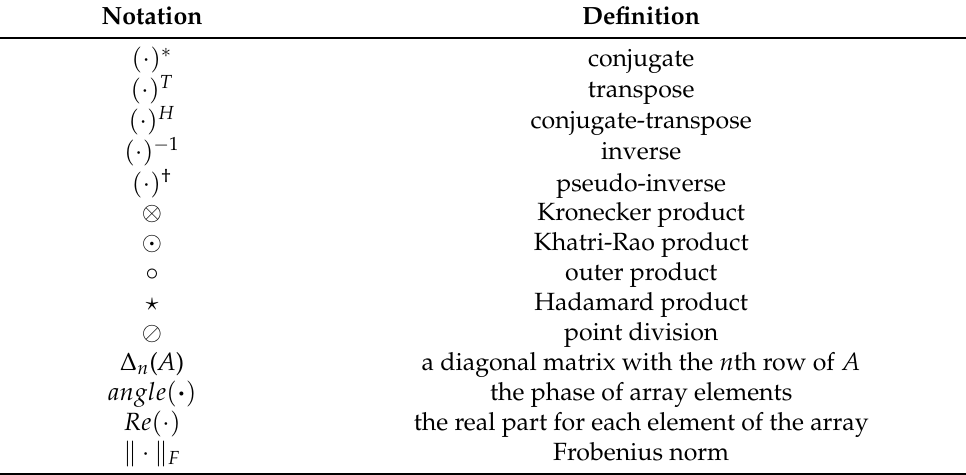
Table 1. Related